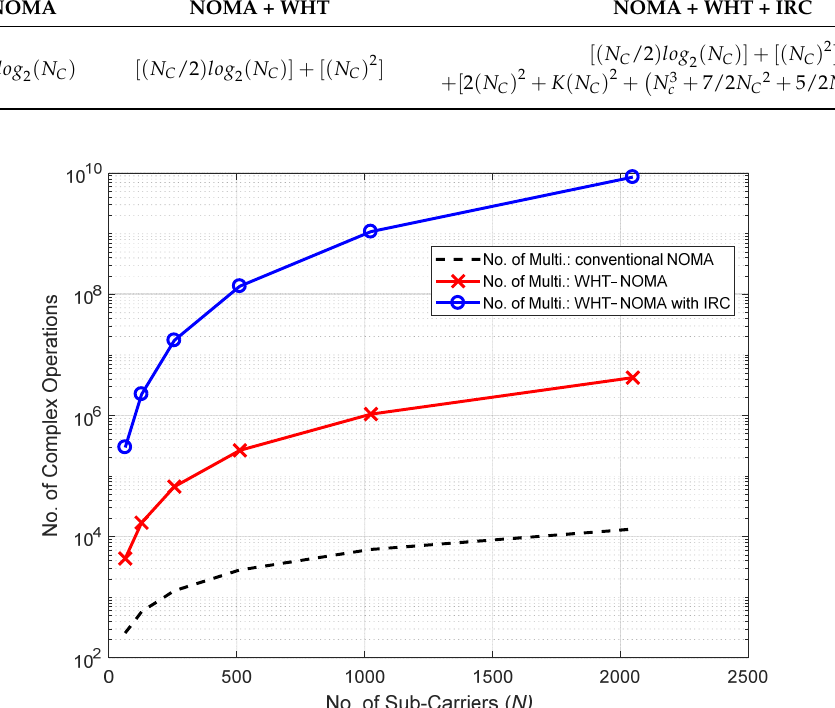
Figure 22. Number of operations for conventional NOMA, WHT-NOMA, and WHT–NOMA–IRC.